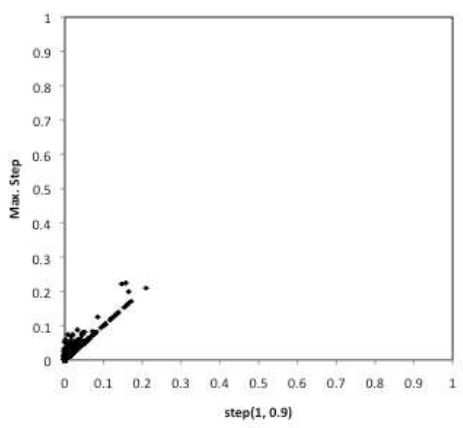
Fig. 3. maxStep and step ( 1 , 0 . 9 ) values for the SD game.